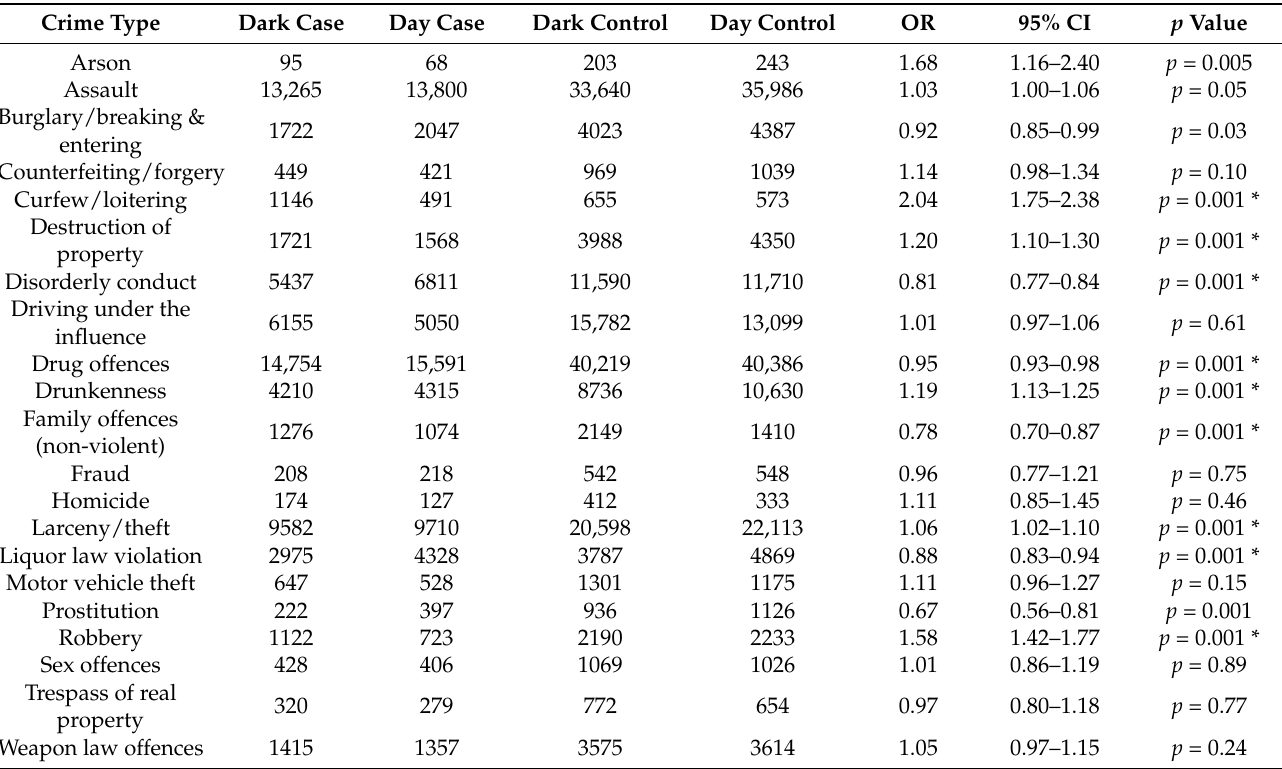
Table 7. ORs and 95% CIs associated with the change in risk at dark compared to daylight according to type of crime. These are estimated case and control data for the whole of the USA. The associated p -values indicate whether the OR is significantly different to